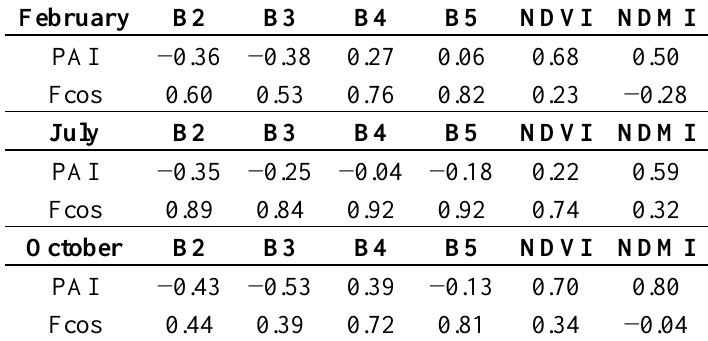
Table 4. Pearson correlation coefficients (r) for PAI/Fcos and radiometric variables at the three